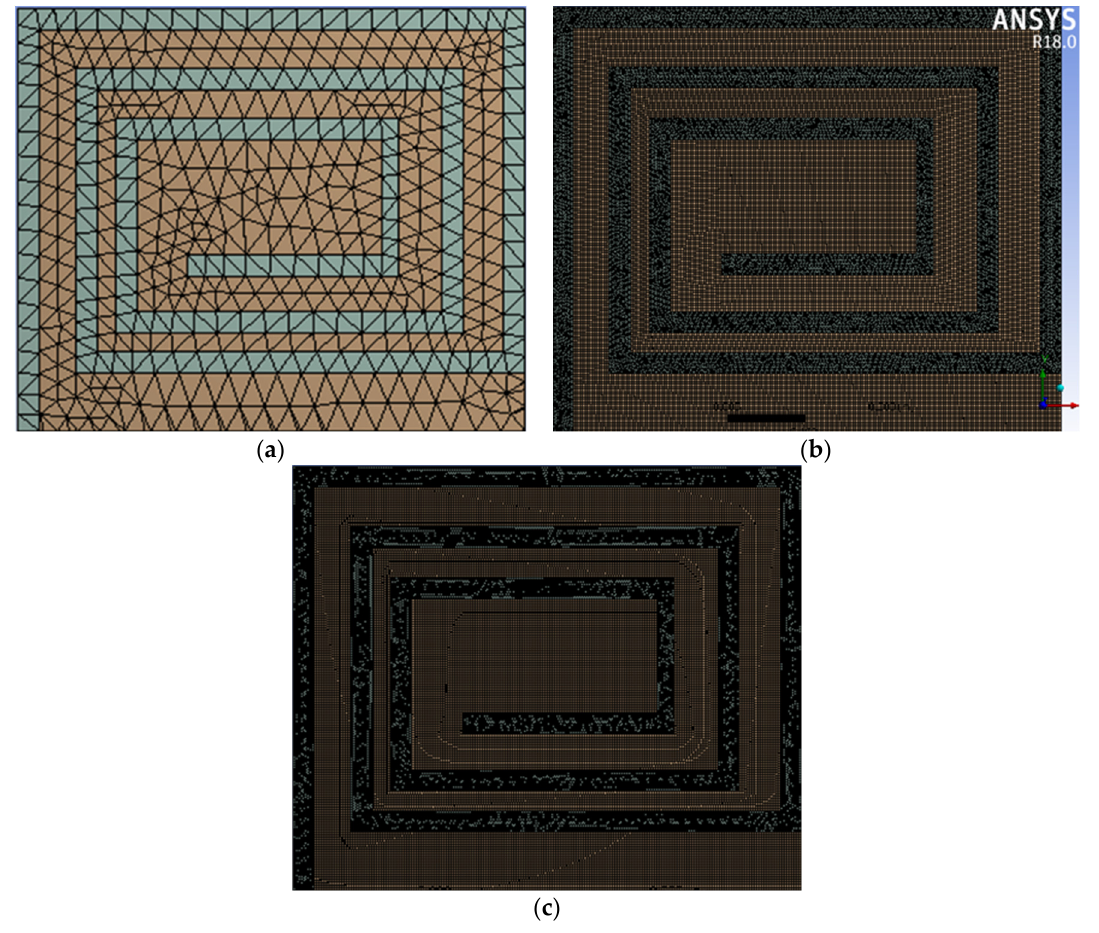
Figure 4. Computational grid: minimum face size = 3.25 × 10 − 4 , maximum face size = 3.25 × 10 –3 . ( a ) Number of elements 12,000; ( b ) number of elements 1,000,000; ( c ) number of elements 1,263,000.